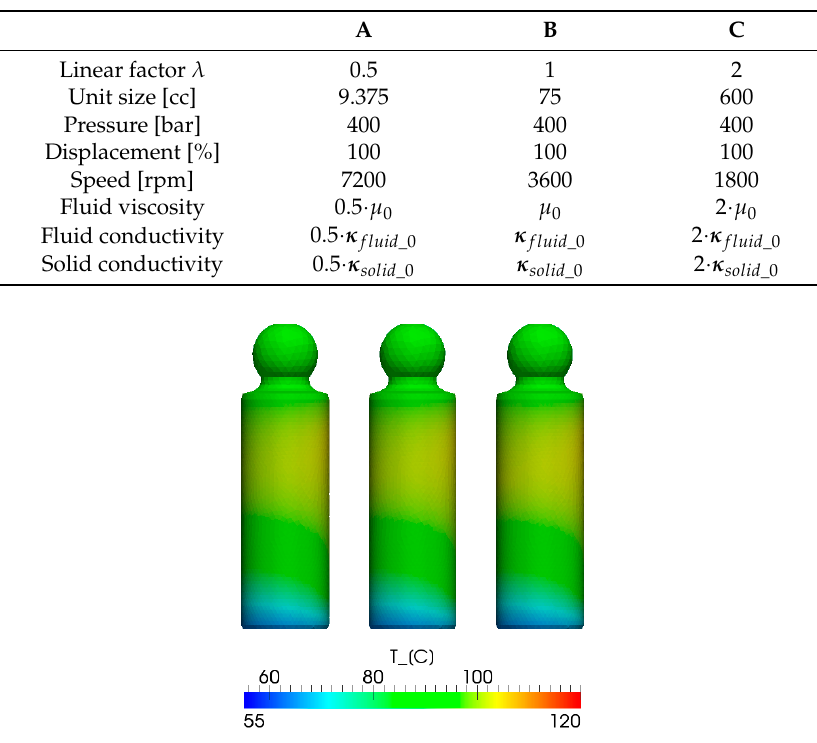
Figure 20. Piston temperature distribution comparison for different sizes.